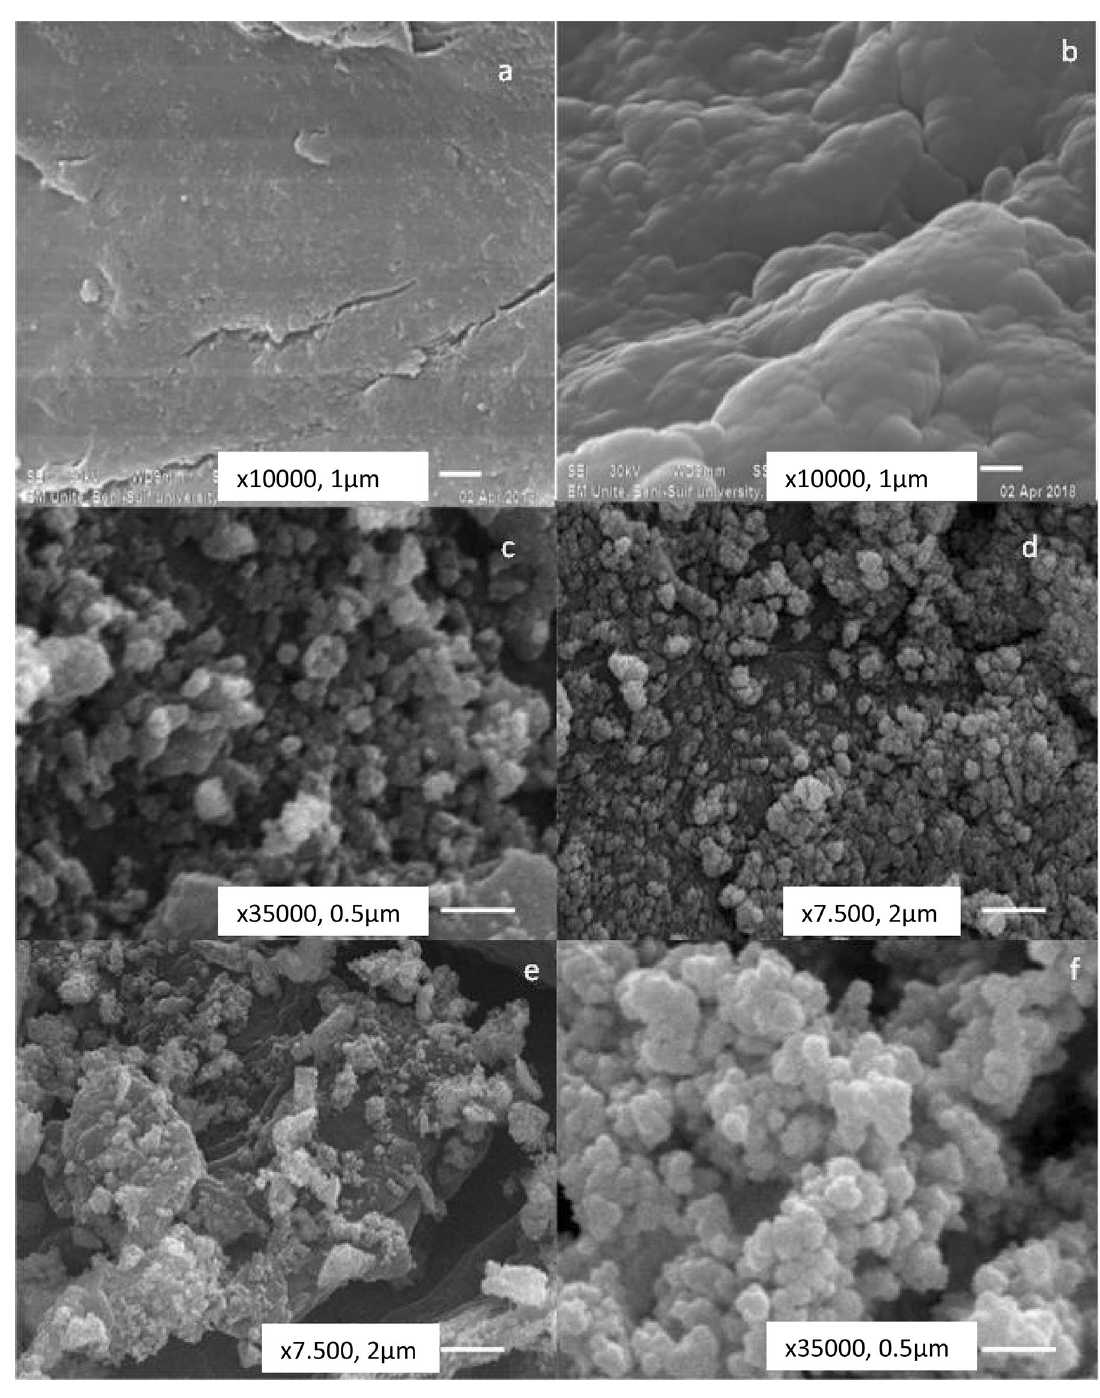
Figure 3. SEM micrographs of the prepared nanocomposites where ( a ) Chitosan, ( b ) Chitosan-4- chloroacetophenone, ( c ) CuO–CeO 2 –Al 2 O 3 , ( d ) CuO–CeO 2 –Fe 2 O 3 , ( e ) CA, ( f )